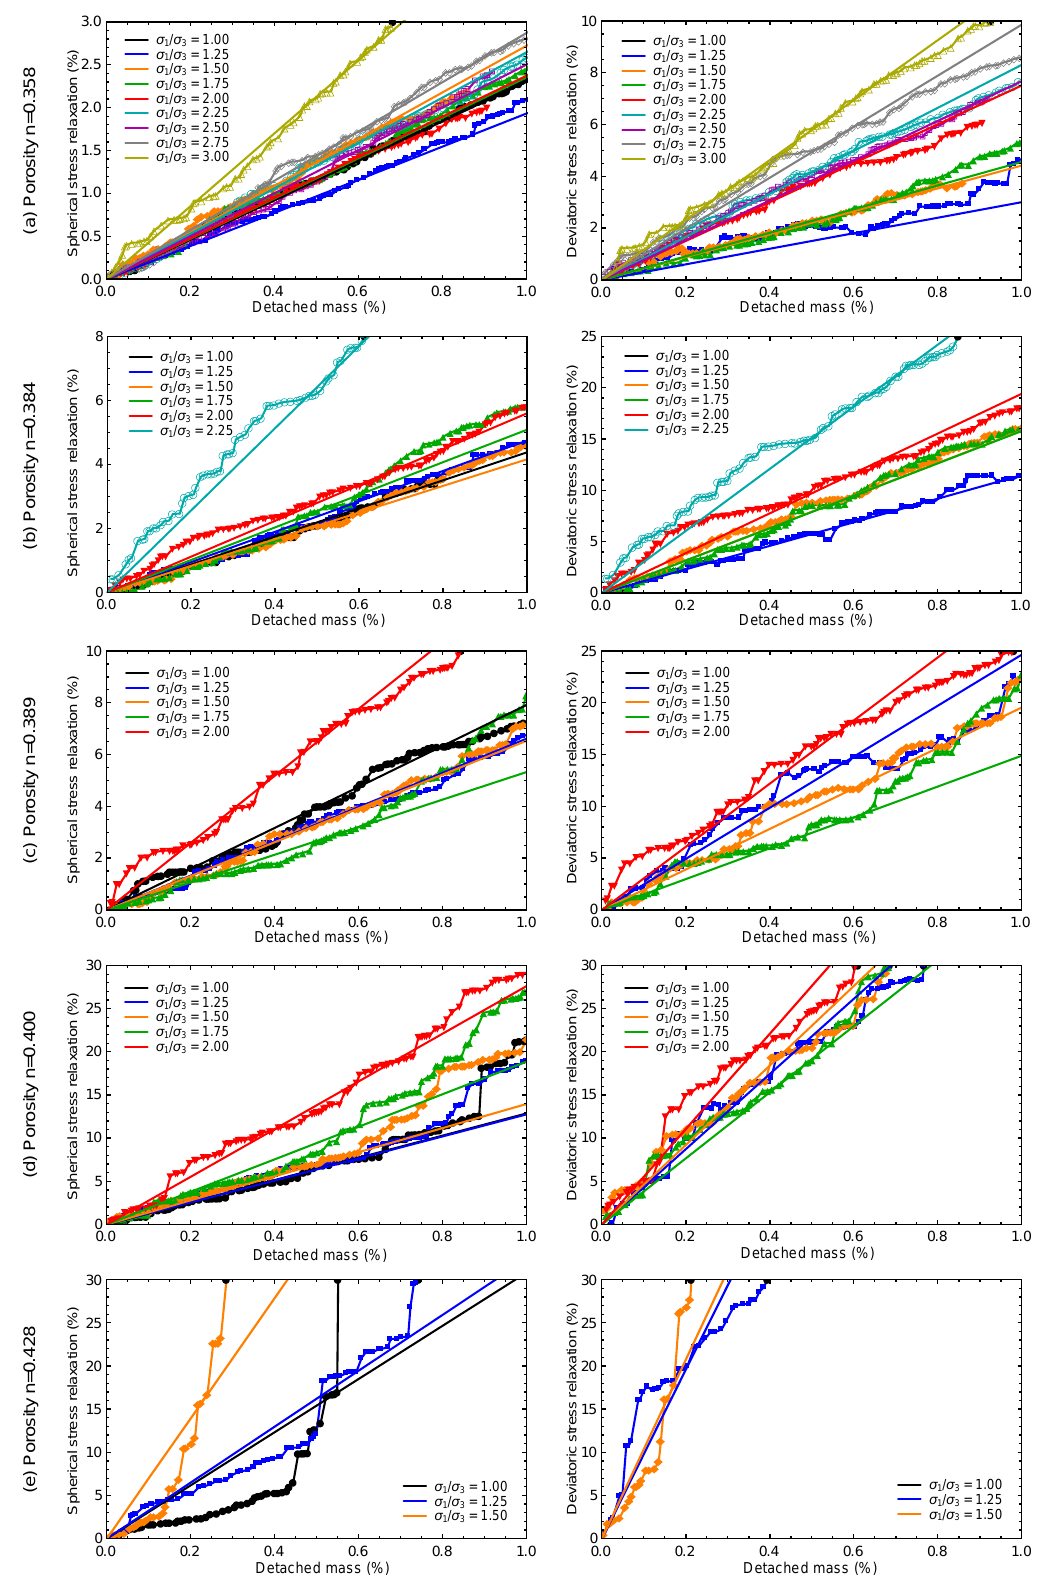
Figure 3. Spherical and deviatoric stress relaxation for various porosity. Colors represent different principal stress ratios (dots = DEM results, lines = fitted linear